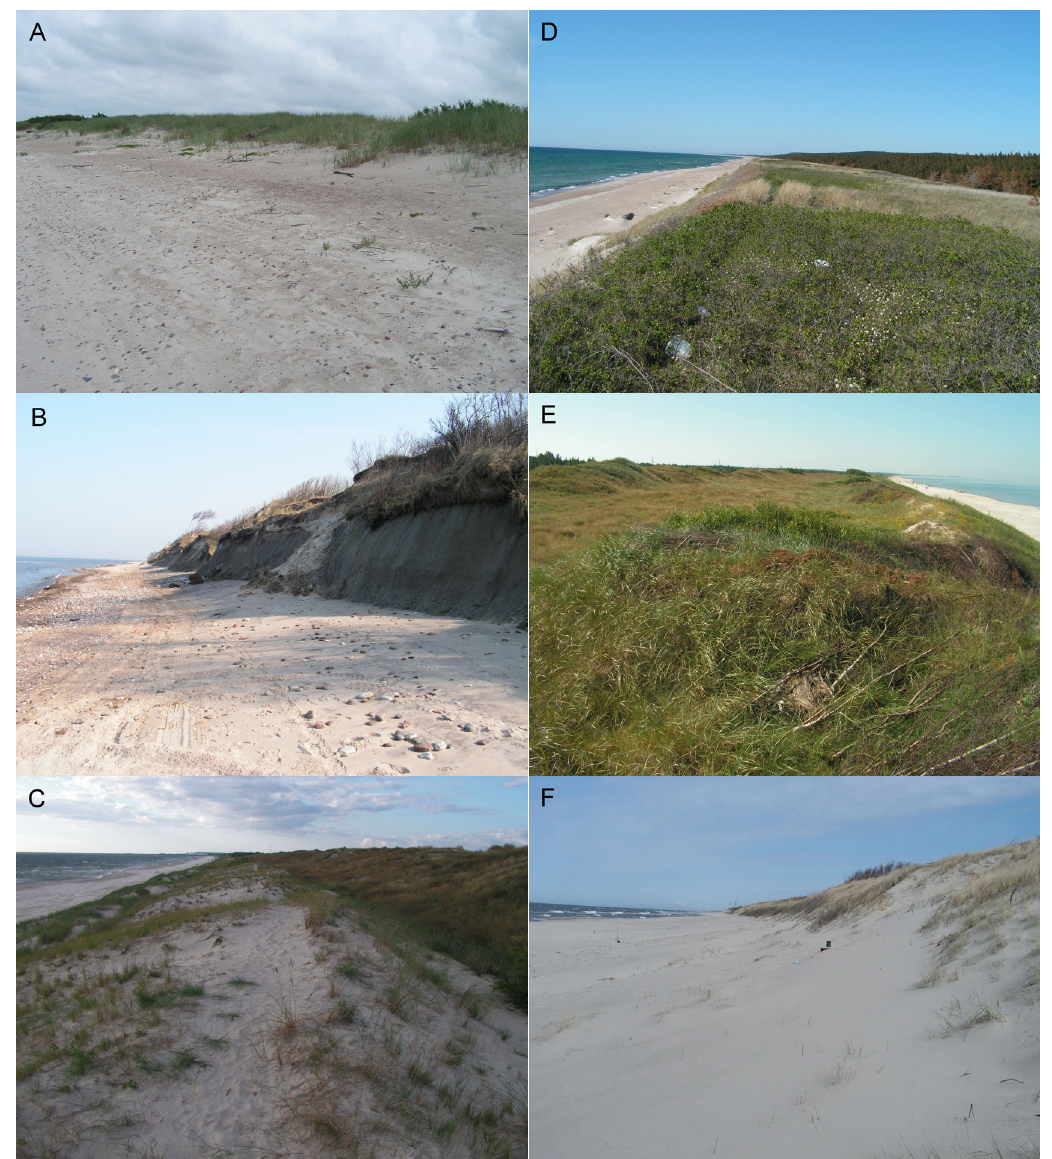
Fig. 2. Sites of measurements. A , B ū ting ė ; B , (cid:138)aipiai; C , Smiltyn ė ; D , Juodkrant ė ; E , Pervalka; F ,